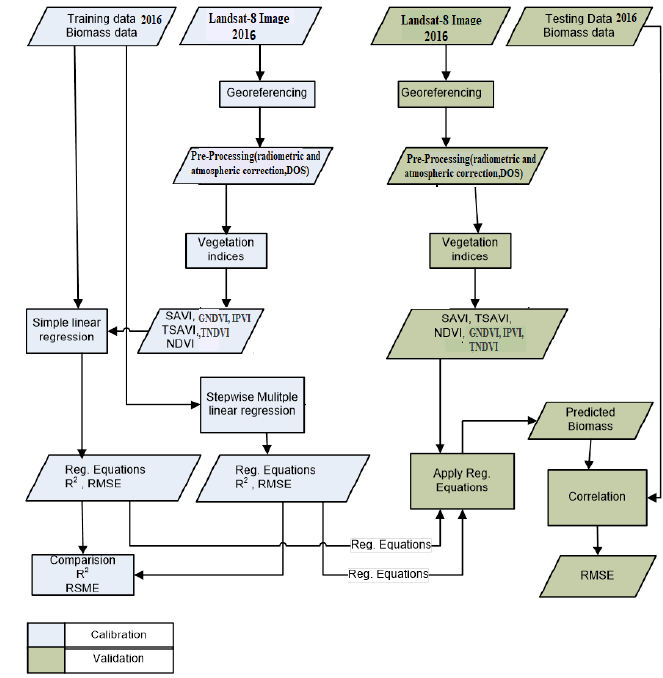
Figure 2. Working